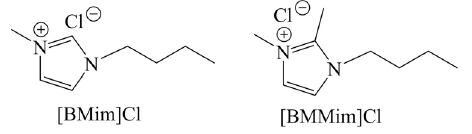
Table 4. Catalytic conversion of GlcNAc to